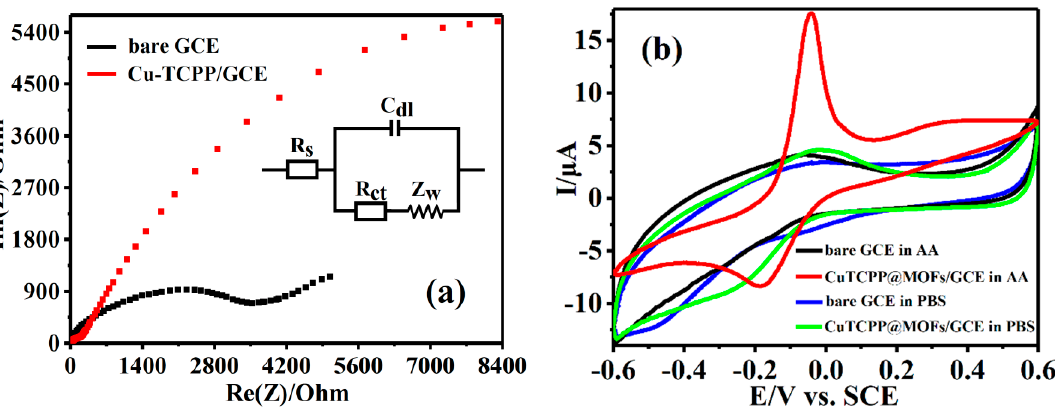
Figure 3. ( a ) EIS of 10 mM [Fe(CN) 6 ] 3 − / 4 − containing 0.1 M KCl using different materials modified